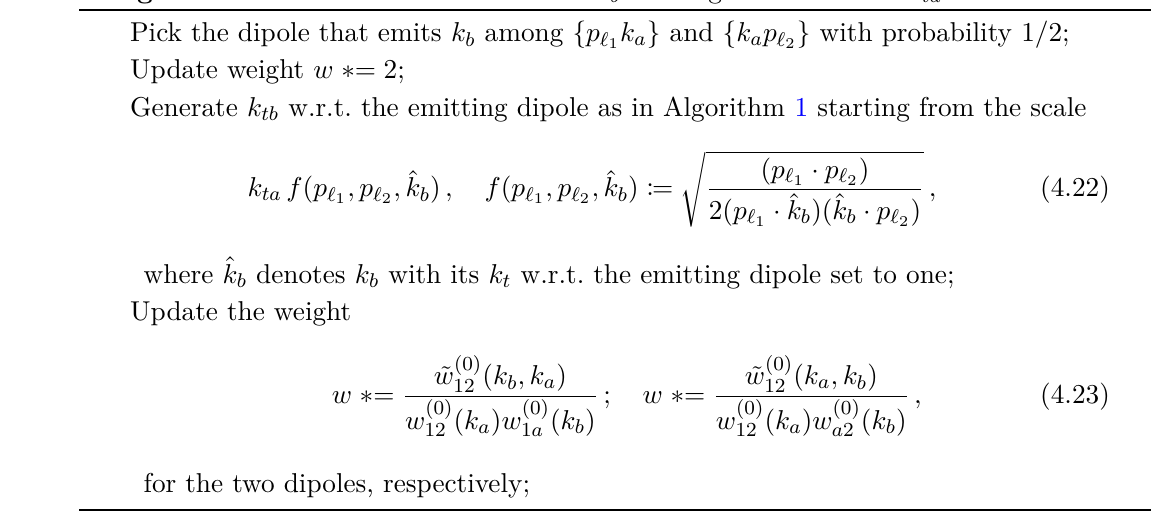
Algorithm 4.4: Generation of emission k